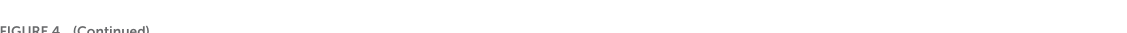
FIGURE4 (Continued) c-FOS/tdTomato/FG triple-labeled neurons in the Vpdm in the control mice (J) and the 2-week UAC mice (K) . Scale bar: 200 µ m. Bottom: The enlarged triple-labeled neurons in the white square, with the double arrowheads indicating c-FOS/tdTomato/FG triple-labeled neurons. The arrows indicate c-FOS/FG double-labeled neurons. And the single arrowheads indicate the tdTomato/FG double-labeled neurons. Scale bar: 20 µ m. (L) Schematic diagram verifying the Vpdm VGLUT1 -VPM pathway by AAV2/9-hSyn-DIO-Synaptophysin-mCherry injection into the Vpdm of VGLUT1-IRES-Cre mice. (M) The expression of the synaptophysin-mCherry injection site in the Vpdm. Scale bar: 200 µ m. (N1–N4) (Top) Triple-immunofluorescence histochemical staining of VGLUT1/NeuN/mCherry in the VPM showed that synaptophysin-mCherry-labeled terminals were coexpressed with VGLUT1 and were observed in close apposition on the NeuN-labeled VPM cell bodies. The double arrowheads indicate VGLUT1 + /mCherry-terminals near NeuN-labeled cell bodies, while single arrowheads indicate VGLUT1-/mCherry-terminals near NeuN-labeled cell bodies. The arrows indicate areas of intense VGLUT1 immunostaining that does not colocalize with mCherry-terminals. Scale bar: 20 µ m. (Bottom) The enlarged area in the white square in (N1–N4) . VGLUT1/mCherry double-labeled terminals were in close contact with NeuN-labeled neuronal cell bodies (double arrowhead). Scale bar: 5 µ